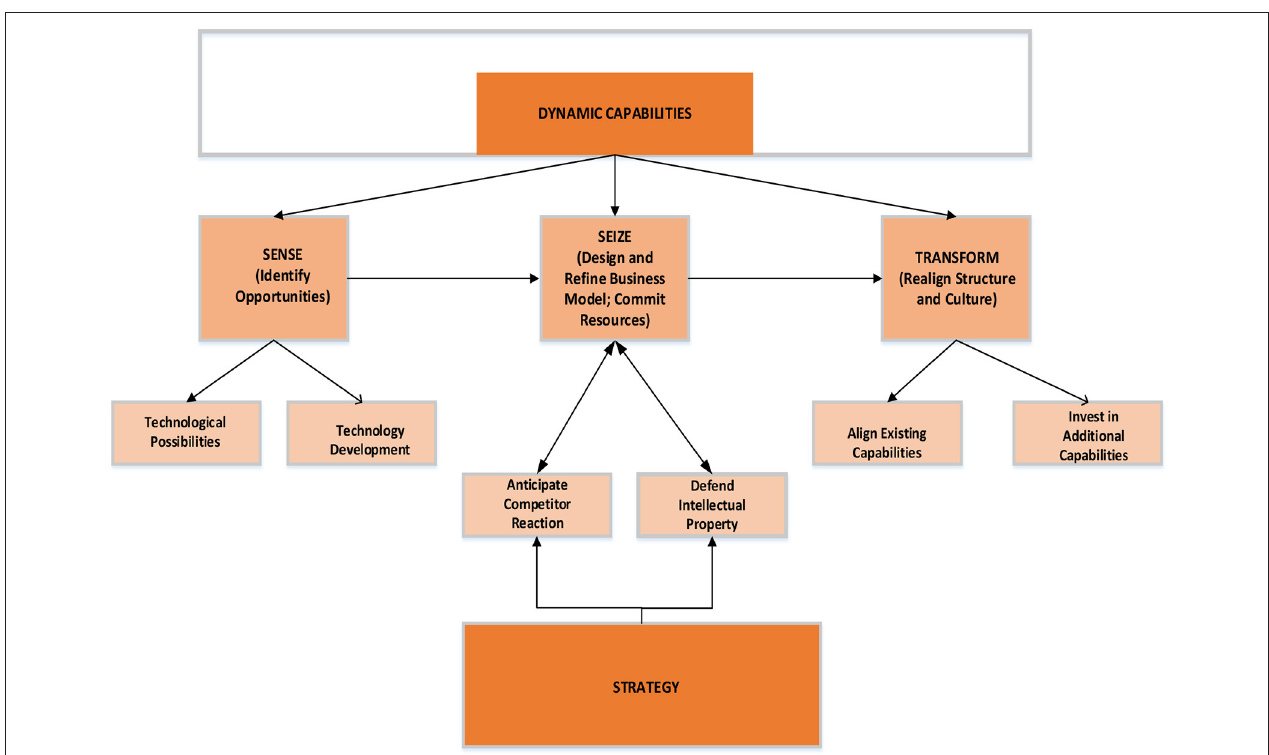
FIGURE 2 | Alignment between dynamic capabilities and strategy (Teece,